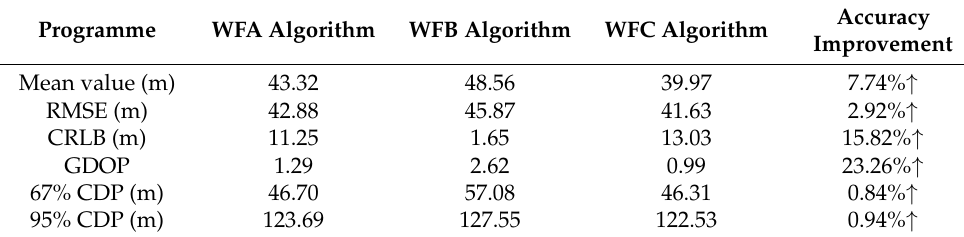
Table 9. Positioning accuracy evaluation